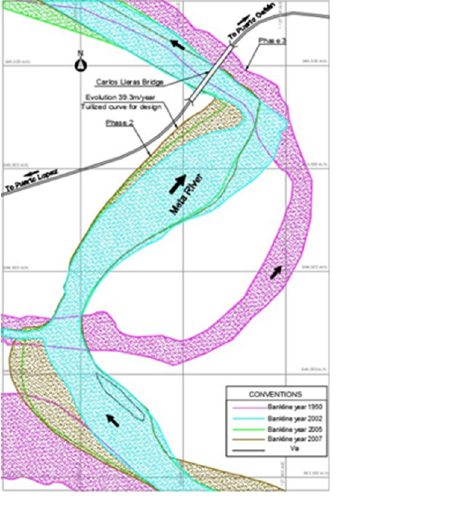
Figure 13. Rio Metica, Puerto López: the two spurs that remain, although highly deteriorated, of the six previously built. For the estimated discharge of 1132 m 3 /s that fills the section, the results of the HEC-RAS model (USACE, 2001 [14]) were used in model BVANE (Odgaard [10]) (Figure 14) to design the vane field for units of 1.50 × 4.50 m. The general parameters used were as follows: Water temperature, (T °C)